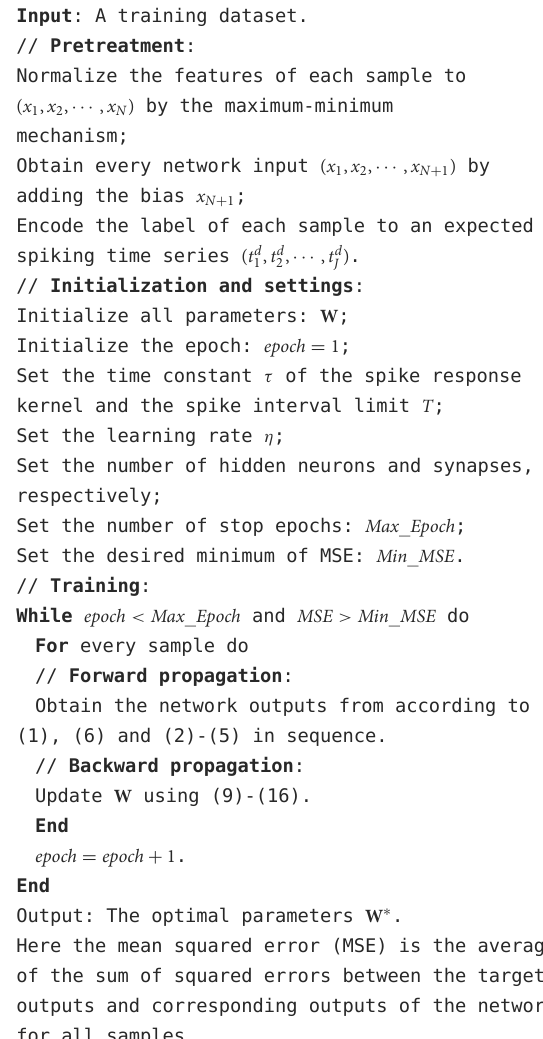
TABLE 1 Details of eight benchmark